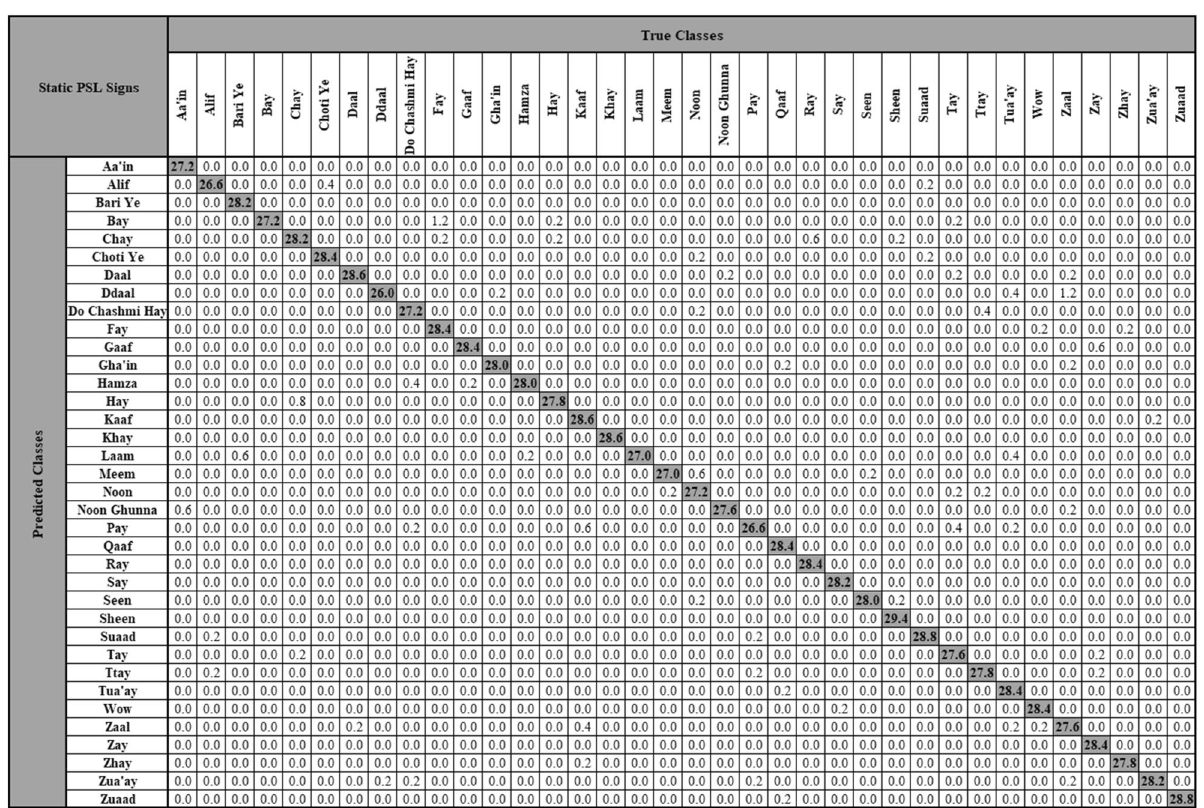
Figure 7. Confusion matrix of static PSL signs at 750 × 750 image dimensions and 500 bags.